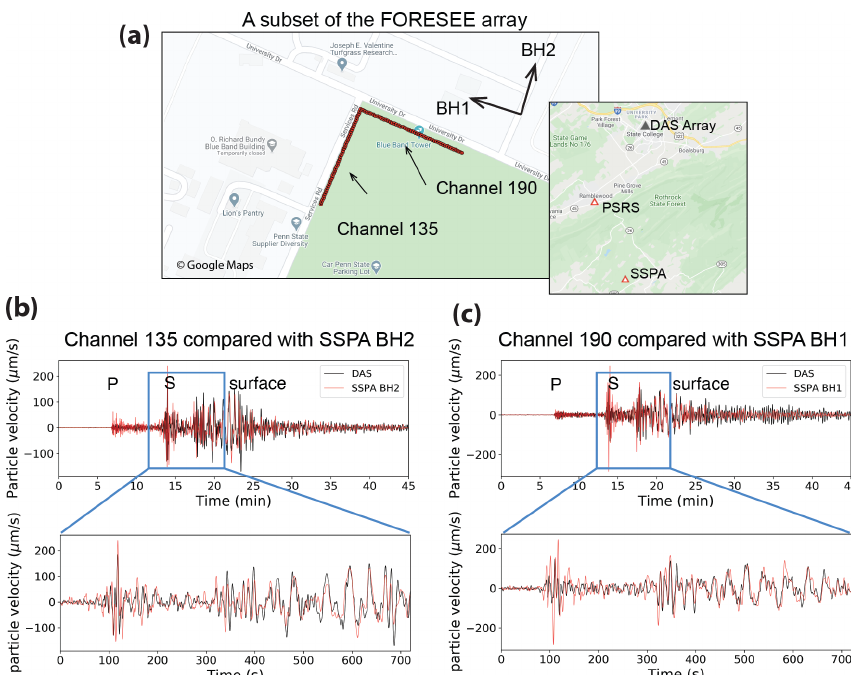
Figure 4. (a) Locations of 80 channels of the fiber array we used for calibration. Top shows the azimuth of two horizontal channels of SSPA, a nearby seismometer 17.7km away. (b) Comparison of channel 135 (black) with BH2 component of SSPA (red). (c) Comparison of channel 190 (black) with BH1 component of SSPA